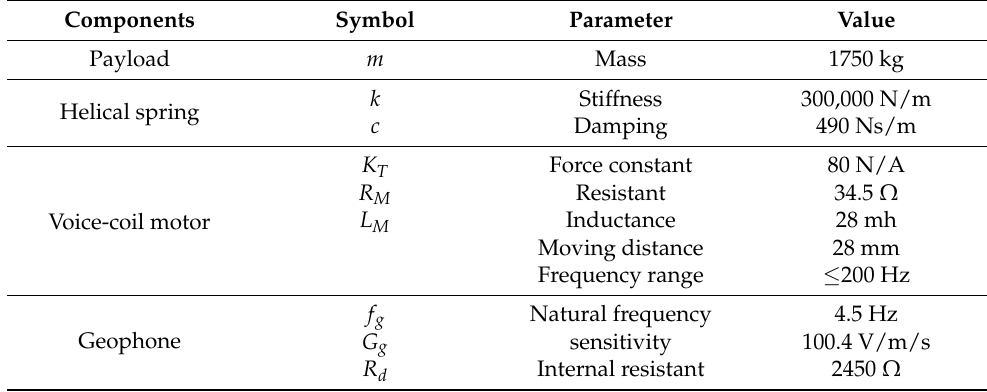
Table 2. Specifications of components in AVRS.